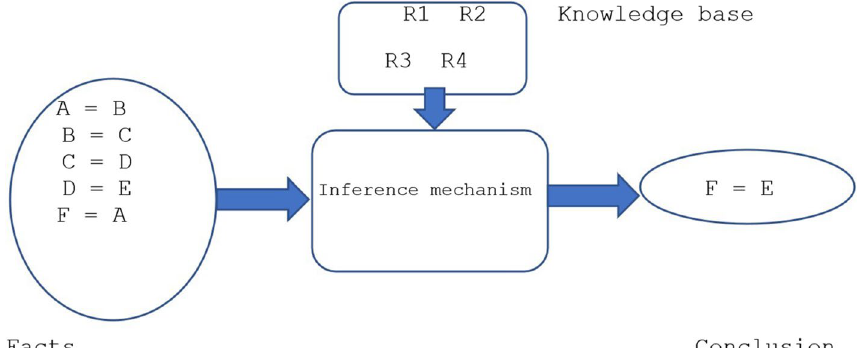
Fig. 2 Knowledge base features (Source: Matelli (2008))